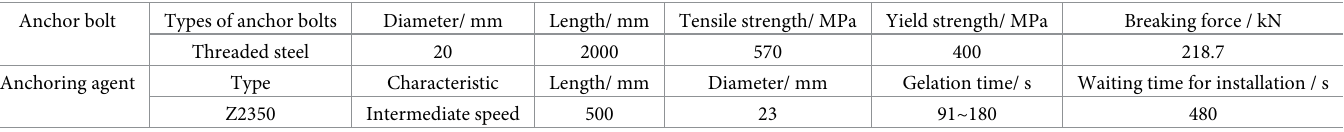
Table 1. Parameters of mechanical properties of the test